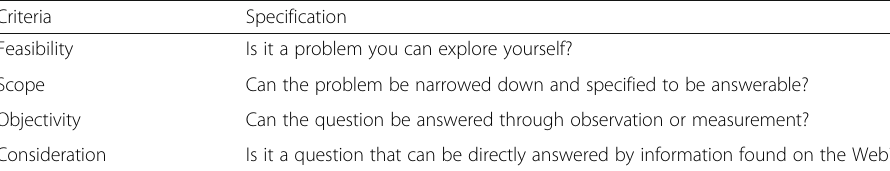
Table 1 Inquiry problem criteria